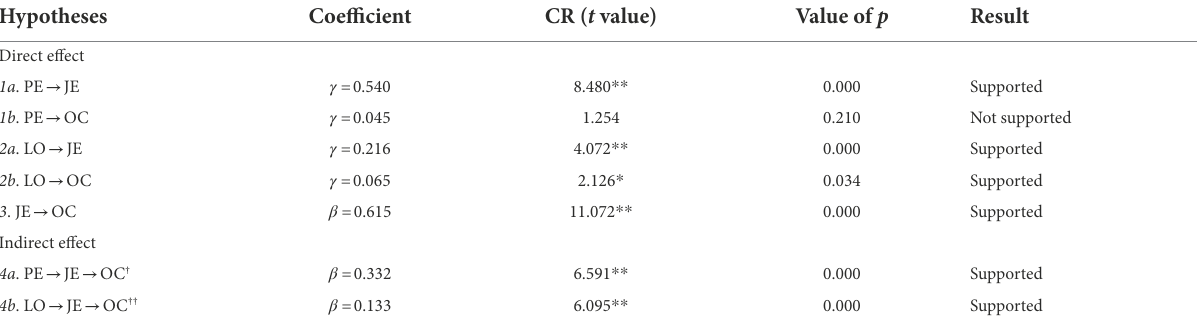
TABLE 3 Direct and indirect effects in structural and competing